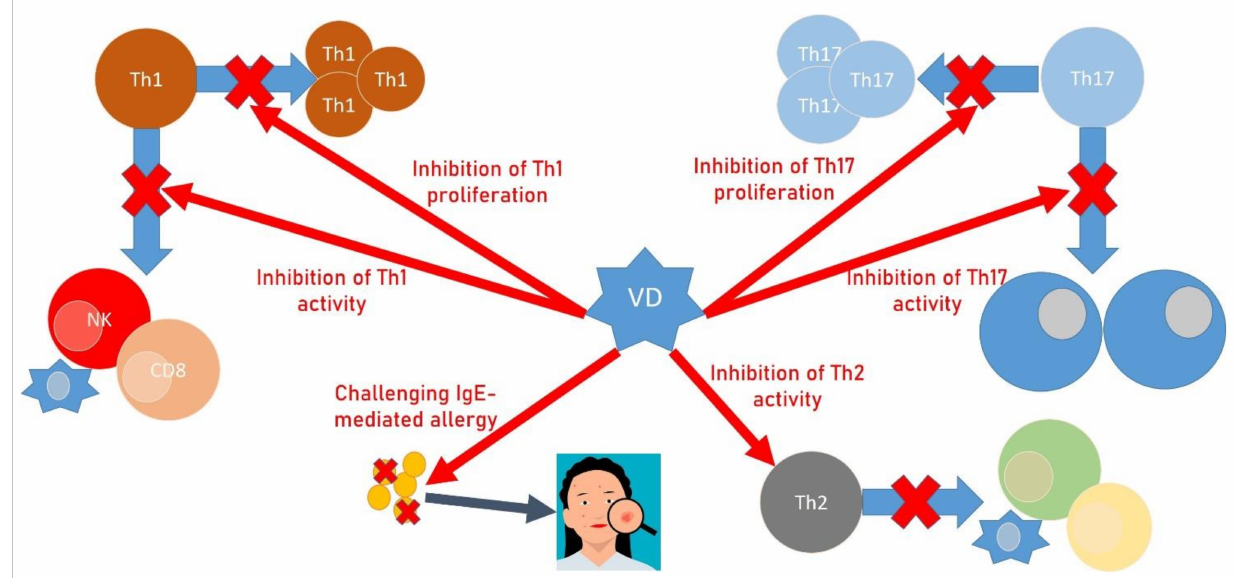
Figure 2. Vitamin D, bone alterations, and allergy. VD acts by skewing T lymphocytes to Th2 polarization and inhibits Th1 and Th17 lymphocyte activity and